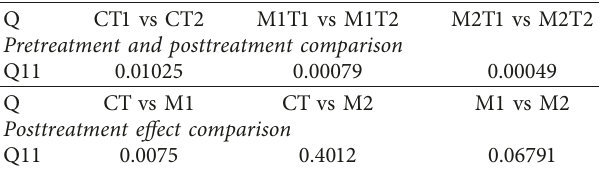
Table 6: Pretreatment and posttreatment comparison in all groups and posttreatment effect comparison between groups: p values of the Wilcoxon signed-rank test. Values are significant at α � 0.05 level.